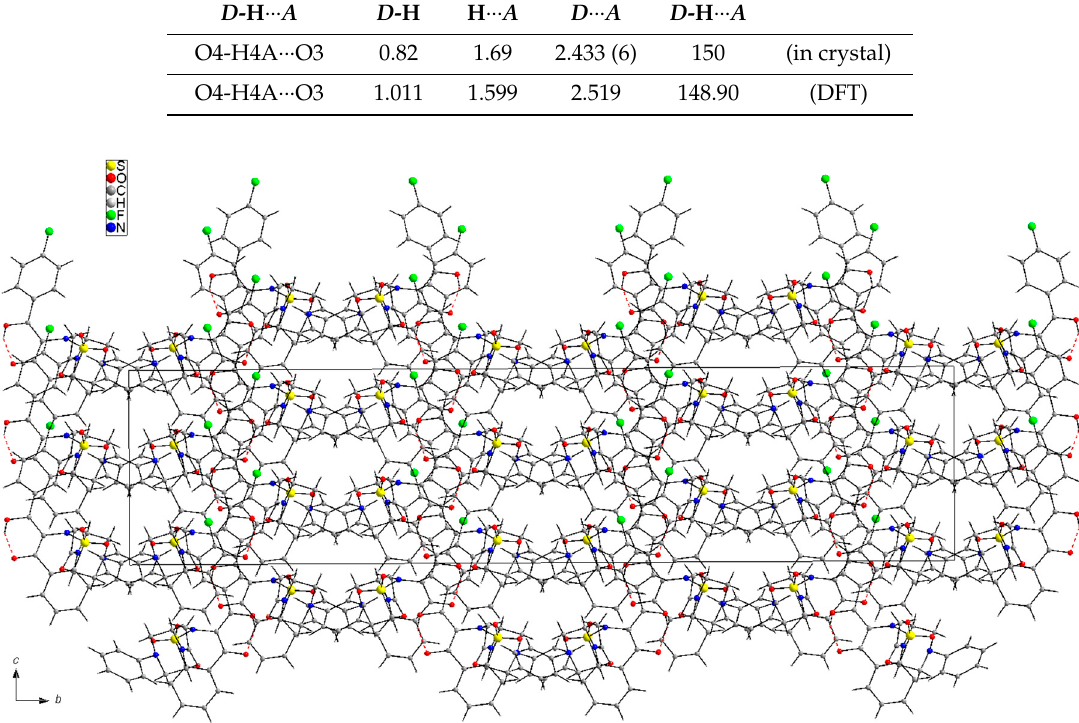
Figure 3. Arrangement of 7i molecules in the unit cell viewed along a-axis. Dashed lines represent the intramolecular O—H … O hydrogen bonds. Table 3. Hydrogen-bond geometry (Å, o ).